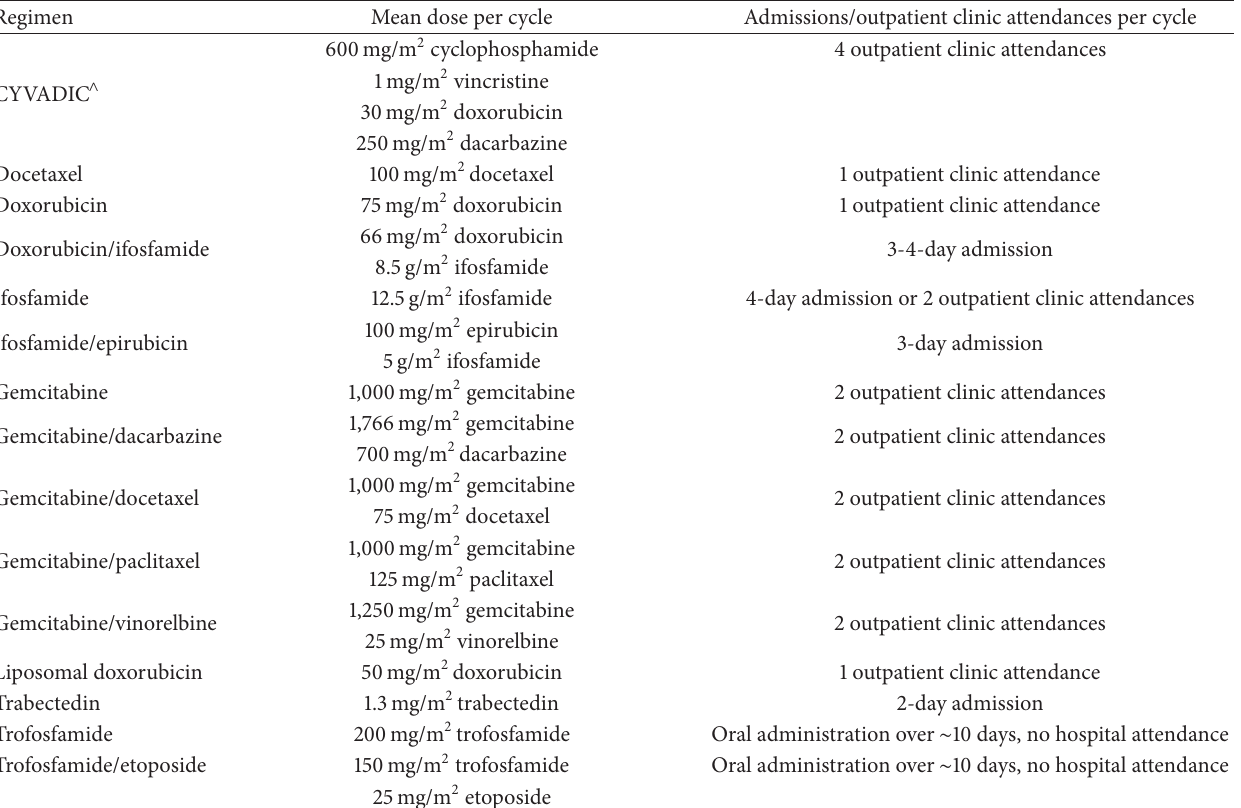
Table 2: Characteristics of chemotherapy regimens incorporated into the